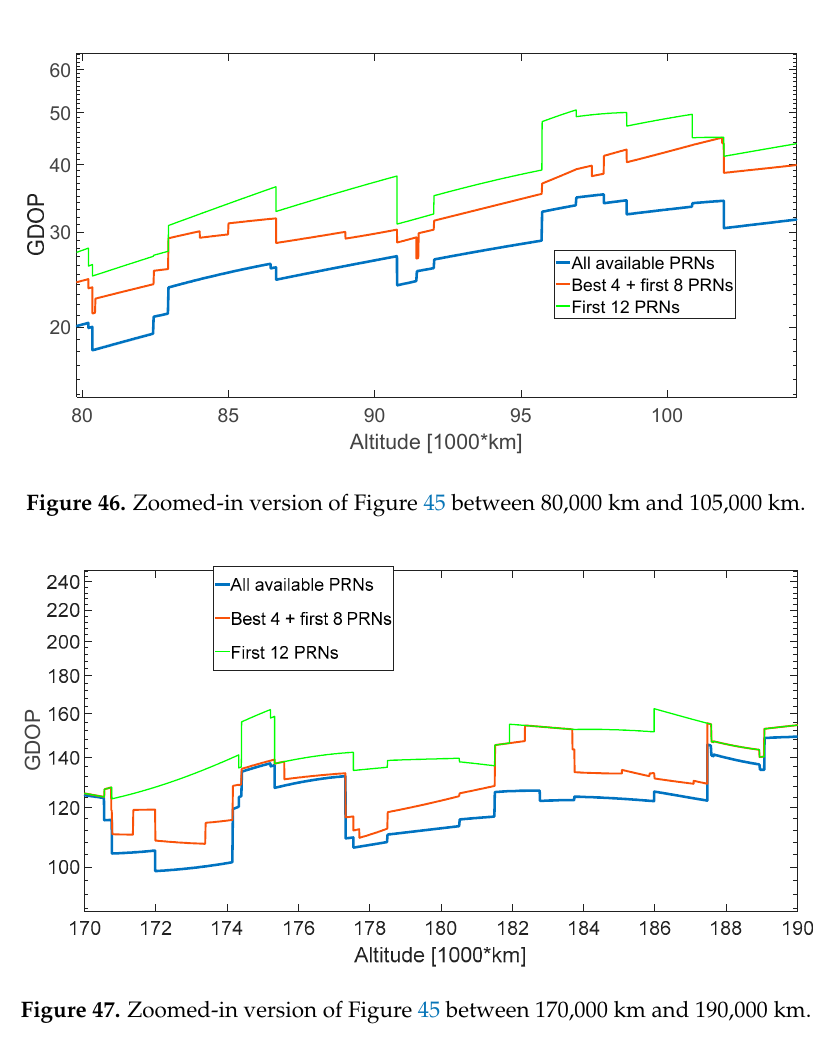
Figure 45. GDOP in three different cases: when all the available signals are processed (in blue), when only the first 12 signals available are processed (in green, i.e., chronologically the first 12 available from 1 to 29), when the four signals that provide the lowest GDOP are included in the 12 processed (in brown).